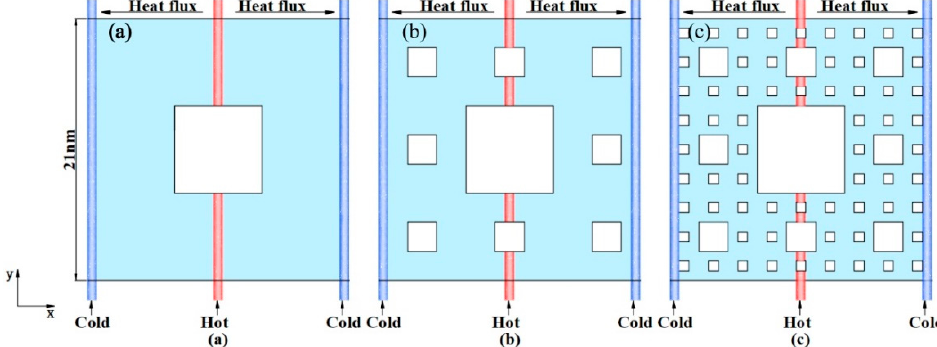
Figure 1. Structure schematics of graphene with different fractal levels ( a ) n = 1 (gra1); ( b ) n = 2 (gra2); ( c ) n = 3 (gra3).